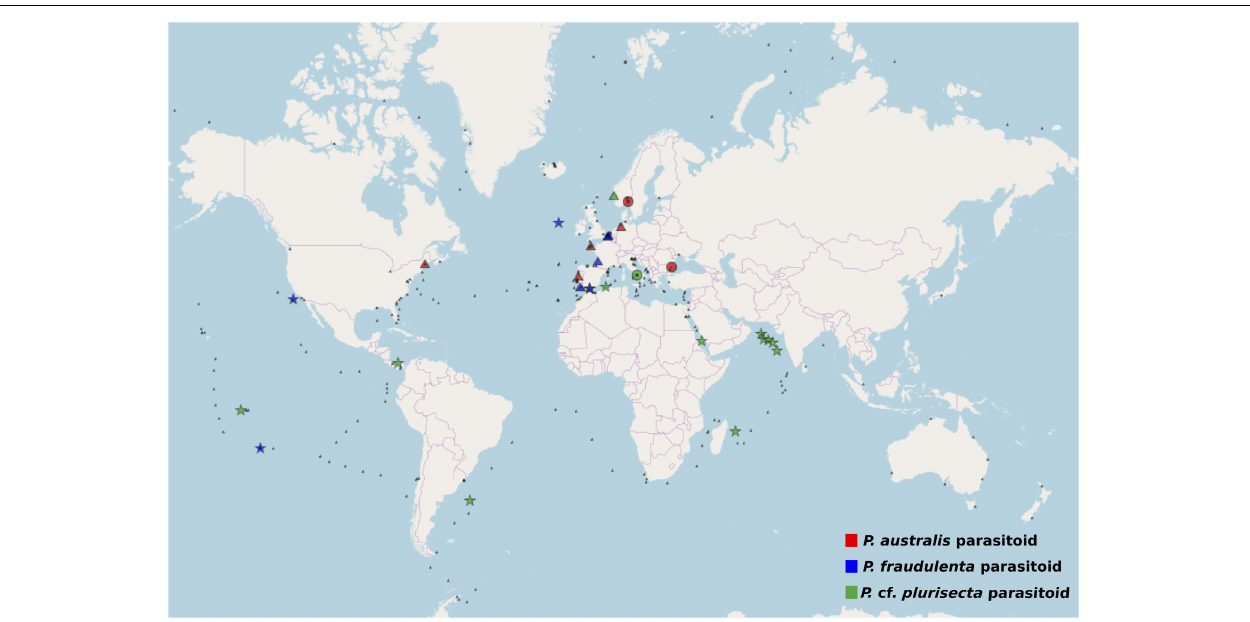
FIGURE 5 | Worldwide screening for the presence of Pseudo-nitzschia oomycete parasitoid barcodes. The metabarcode databases Ocean Sampling Day (triangle), BioMarKs (circle), and TARA (star) were searched for the presence of > 10 paired reads over 99% identical to the V4 or V9 region of the 18S rDNA of the parasitoids P . cf. plurisecta 12-150 (green) within OOM_2; P. fraudulenta 13-374 (blue), P. australis 10-044/10-045 (red) within OOM_1. Small black symbols show the absence of reads matching the searched organisms in the relative